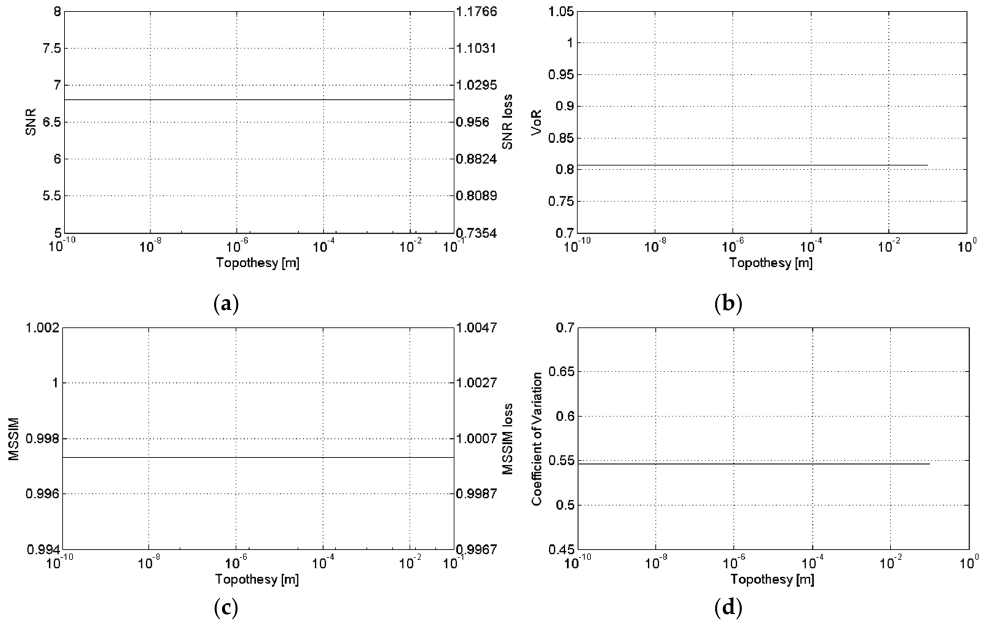
Figure 7. Sensitivity of SB-SARBM3D against the topothesy: ( a ) SNR; ( b ) VoR; ( c ) MSSIM; ( d ) coefficient of variation.